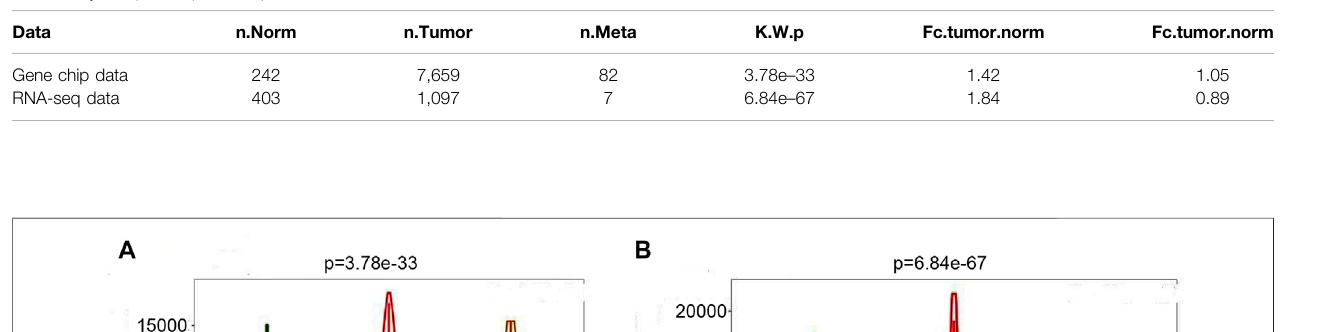
TABLE 2 | Compare expression pro fi les of tumor, normal and metastatic